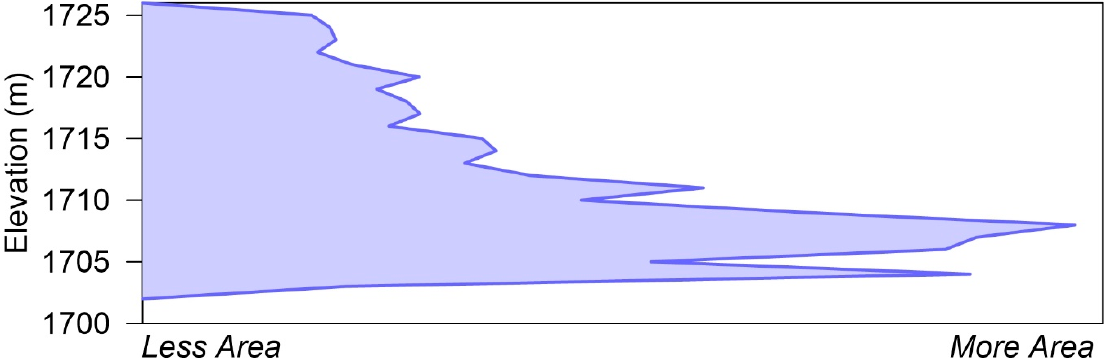
Figure 16. Hypsometry of the Lake Clover basin. Irregularities in the area-altitude distribution would have affected the overall rate of water-level lowering during regression.